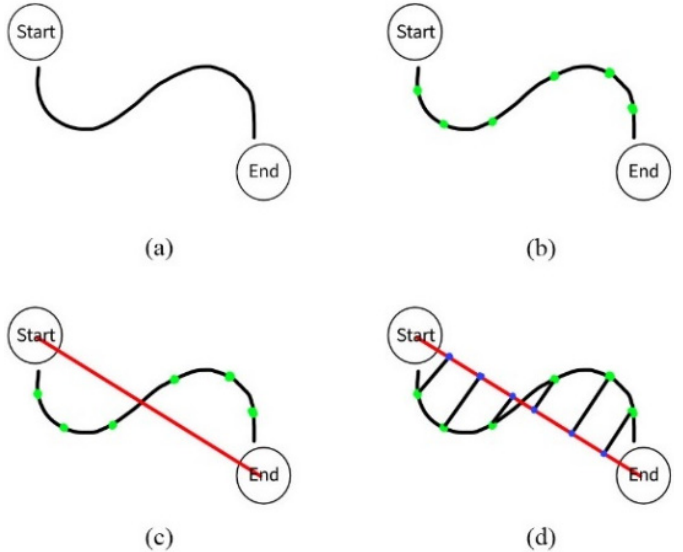
Figure 6. ( a ) A sketch showing the starting point, goal point, and path between them. ( b ) Green dots represent the midpoint of the path at regular interval. ( c ) A vector (red line) from the starting point to the goal point. ( d ) Projection of midpoints onto the vector in ( c ).